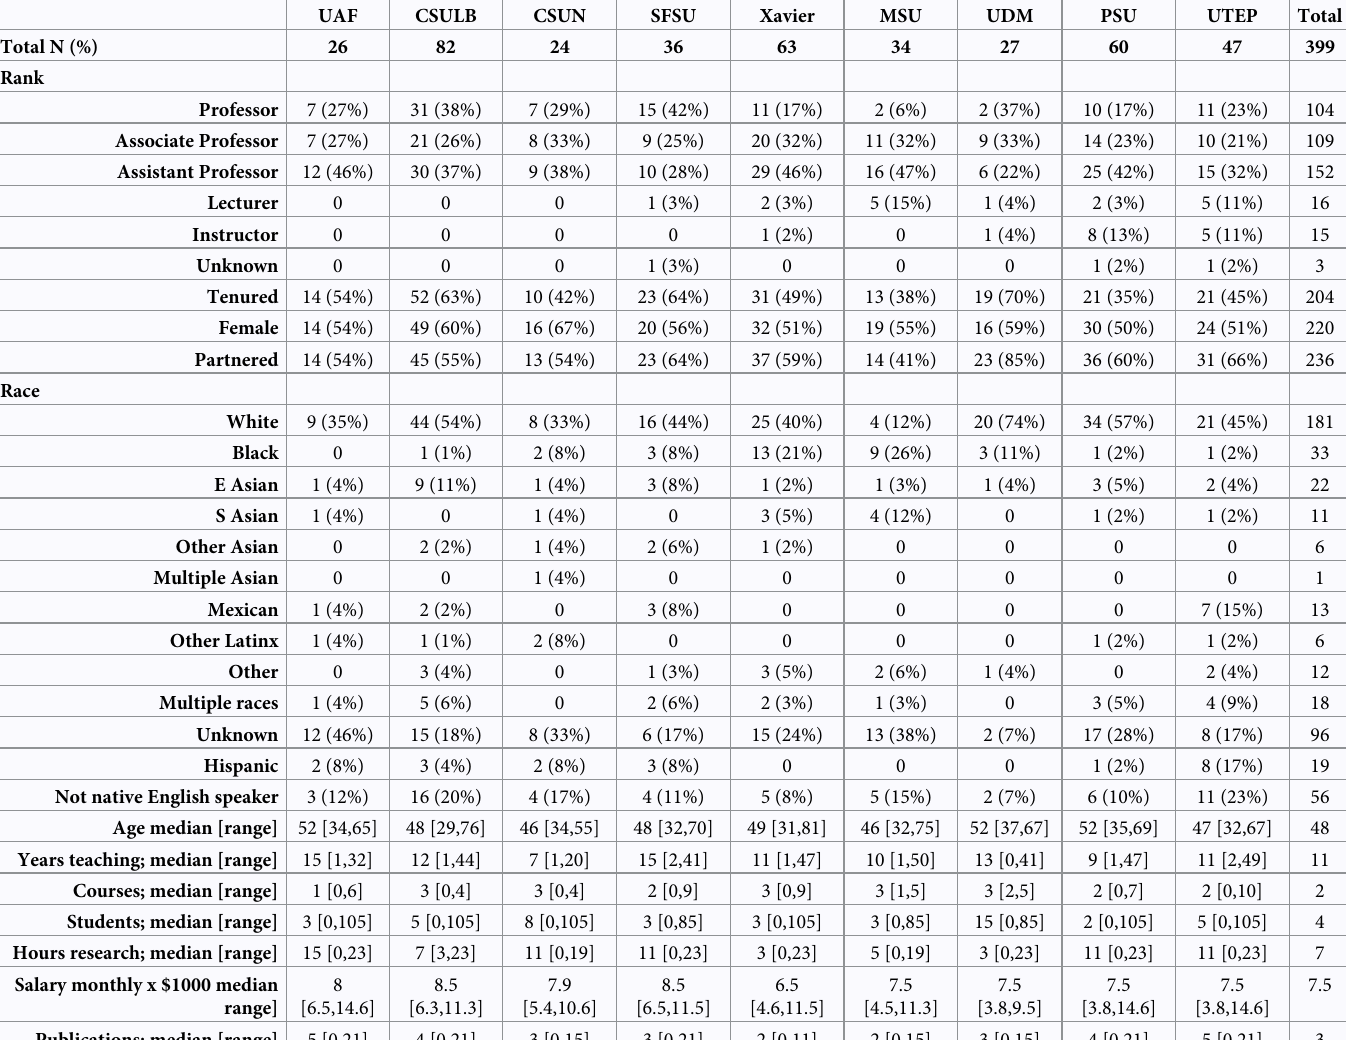
Table 2. Survey characteristics of sites. HERI survey,